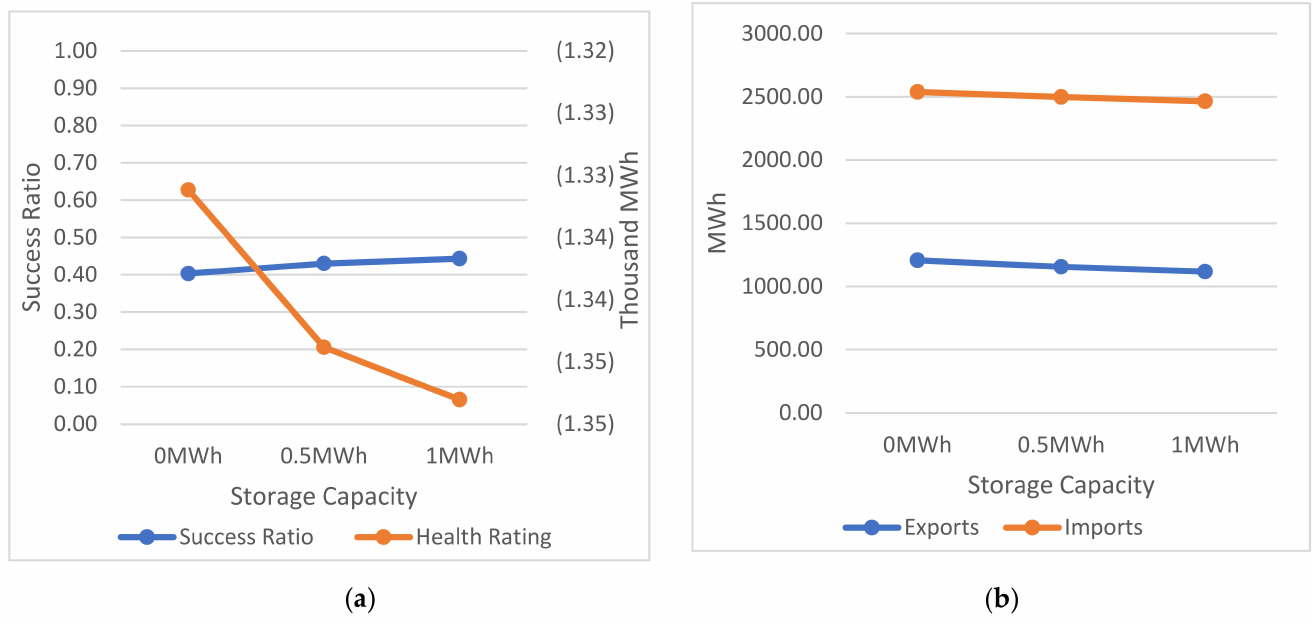
Figure 13. ( a ) The average success ratio and health rating of the grid-connected systems of each charging profile. ( b ) The average annual energy imports of the grid-connected system of the charging